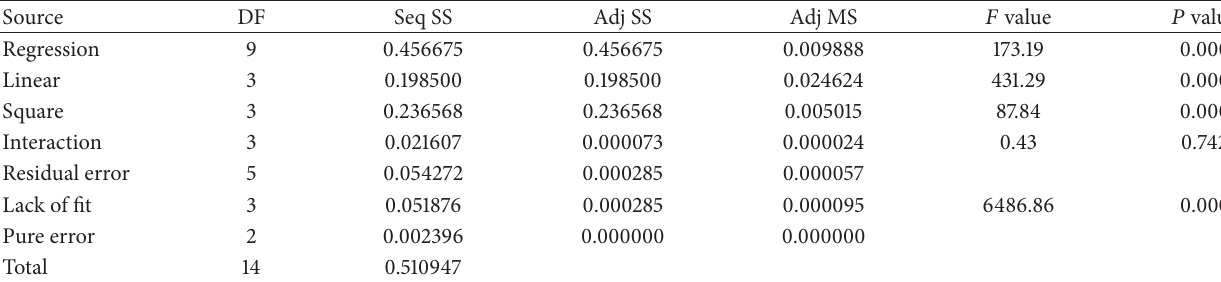
Table 9: Analysis of variance for wear rate.